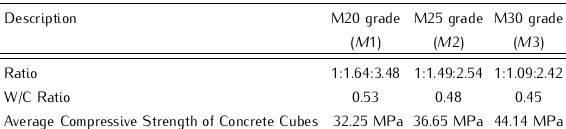
Table 1. Properties of Concrete.